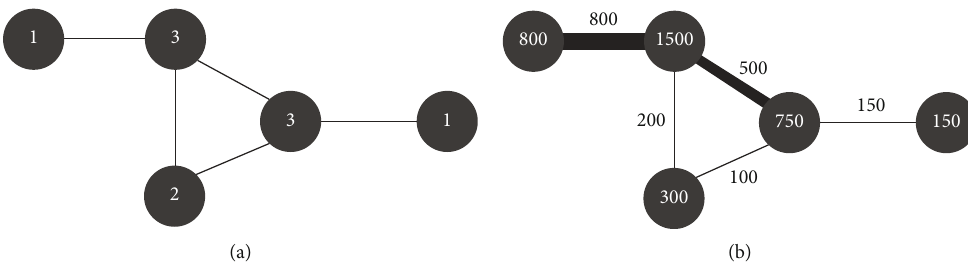
Figure 1: Schematic diagrams of (a) node degree, and (b) node strength in network theory.